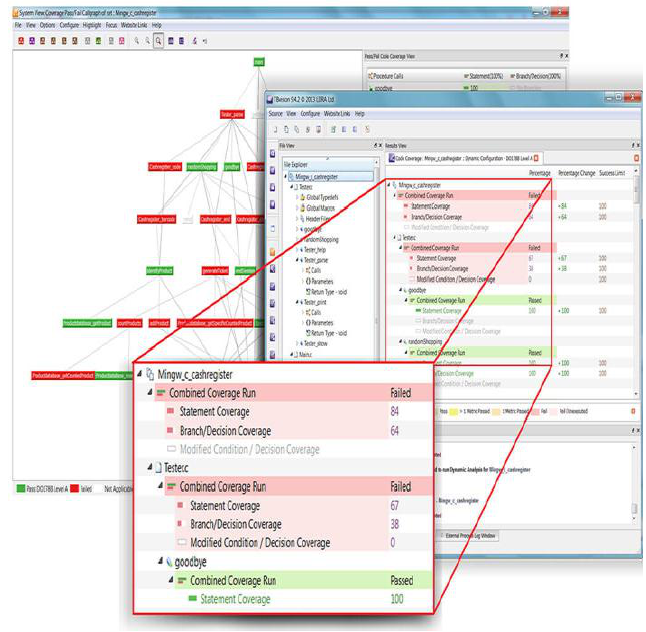
Fig. 1. Flowchart with Code coverage in LDRA